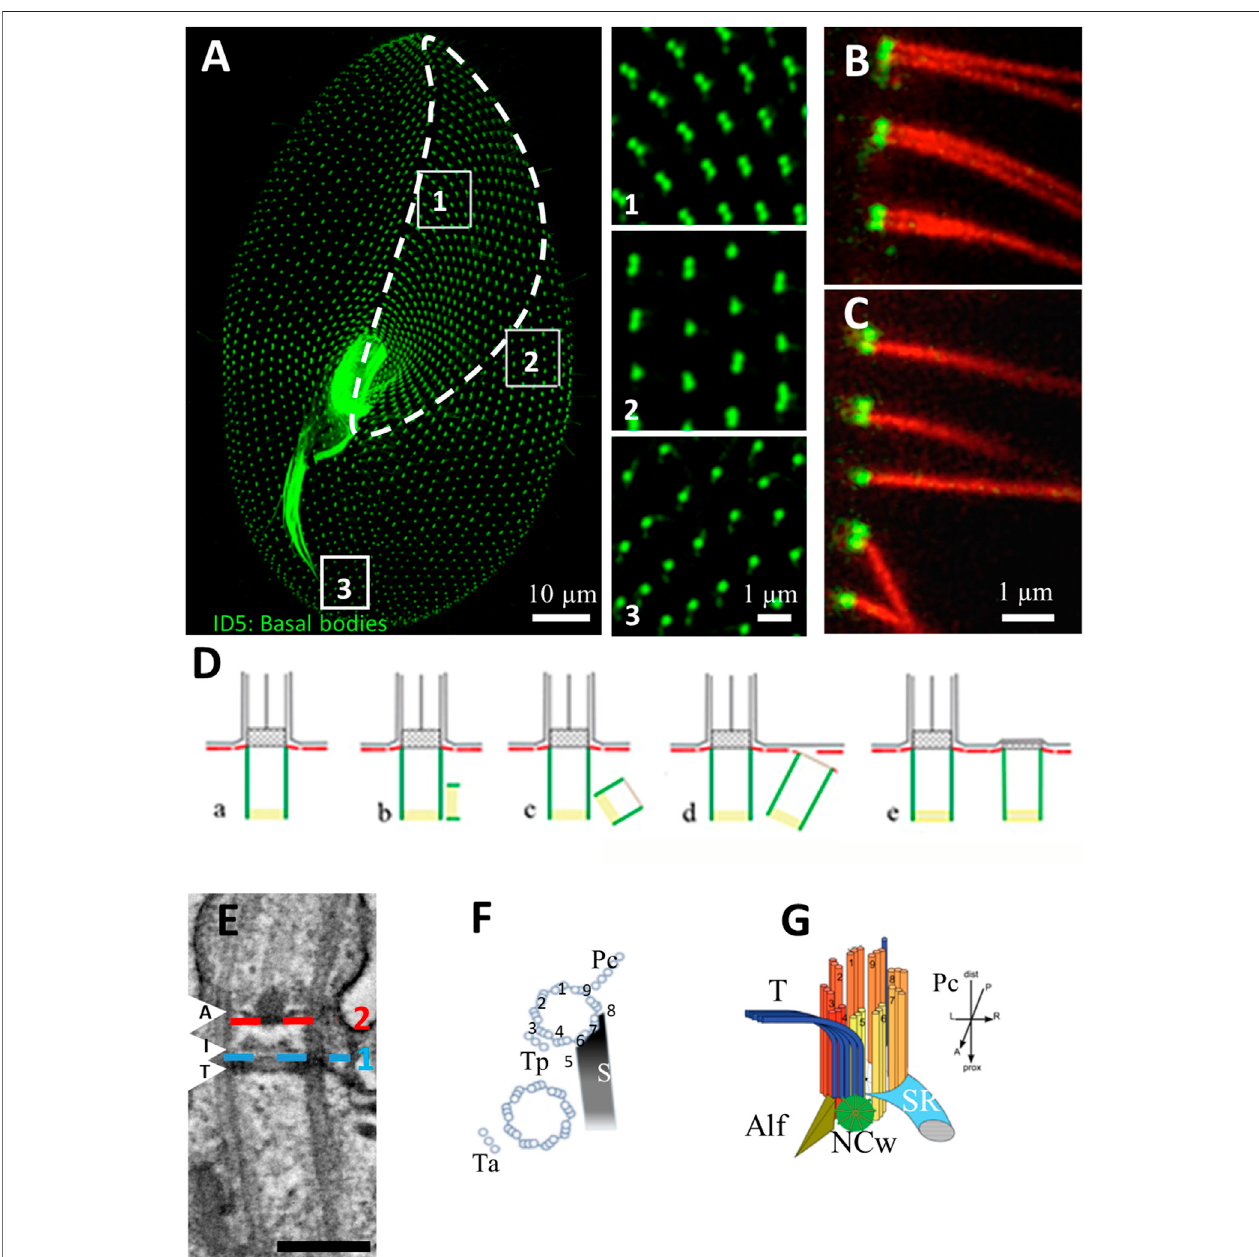
FIGURE 2 | (A) Basal body organization in Paramecium tetraurelia . Basal bodies (BB) are decorated by monoclonal anti-glutamylated tubulin ID5 antibodies (green).Notethatintheanteriorpart ofthecell(area1correspondingtotheinvariant fi eld,tracedinwhite),basalbodiesareorganizedindoublets. Intheposteriorpartof the cell, singlet basal bodies are observed (area 3). In the rest of the cell, doublets or singlets of basal bodies are observed (mixed fi eld, area 2). Scale bar: 10 µm. (B,C) Immuno fl uorescence showing basal bodies decorated by ID5 antibodies (green) and cilia stained by anti-polyglutamylated tubulin (red). Transverse section showing that in the invariant fi eld (area 1), each BB, which are organized in doublets, grow a cilium. Scale bar: 1 µm. (D) Schematic representation of the different steps (A – E) of BB duplication. (E) Longitudinal section of a ciliated basal body observed by transmission electron microscopy Scale bar: 200 nm. The arrows indicated the position of the three layers of the TZ. Terminal plate (T), intermediate plate (I) and axosomal plate (A) . The dotted lines indicate the position of the transition fi bers (1) and Y-links(2). (F) SchemaoftheBBappendagesina2BBunit.Thestriatedrootlet(SR)coursestowardtheanteriorofthecellwhilethepost-ciliaryrootlet(Pc)islocatednear the 8th and 9th microtubule triplets. Also shown are the transverse rootlets on the anterior BB (Ta) and the posterior BB (Tp). (G) 3D representation showing the topographicalrelationshipsofBBanditsanteriorappendages:thestriatedciliaryrootlet(SR),thetransversemicrotubules(T)andtheanteriorleft fi lament(ALF).Thenew BB (green disc). Reproduced/adapted with permission Aubusson et al, 2012. Journal of cell science, 125, 4395-4404 from Jerka-Diadosz et al., 2013.